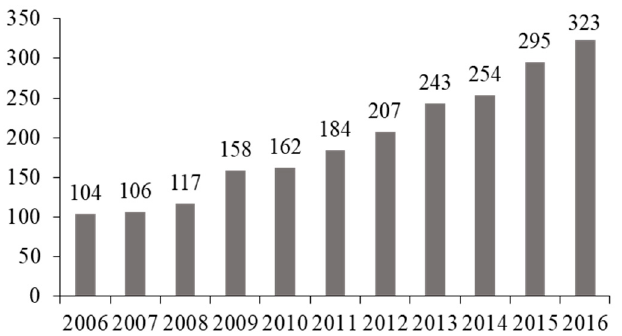
Figure 2. Distribution of RD patients per transition cohort (2006–2016).